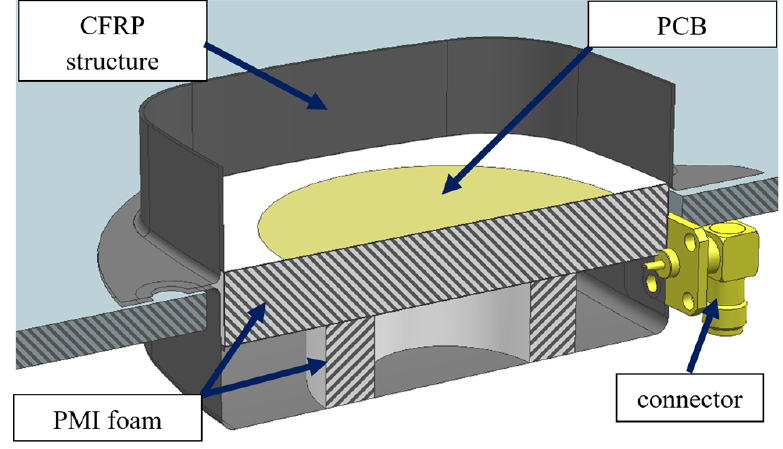
Figure 7. Cross section of the satellite antenna panel used for experimental tests.